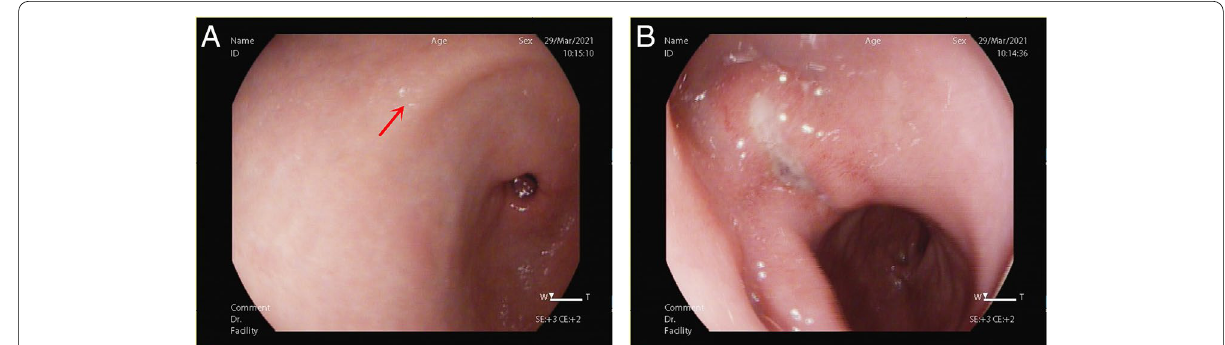
Fig. 1 Gastroscopy revealed congestion and oedema in the mucosa of the gastric antrum, with reddish-white-coloured (predominantly white) and punctate erosions ( A , The red arrow is the biopsy forceps extraction point). A 5 surrounding mucosal congestion, oedema and smudged moss ( B